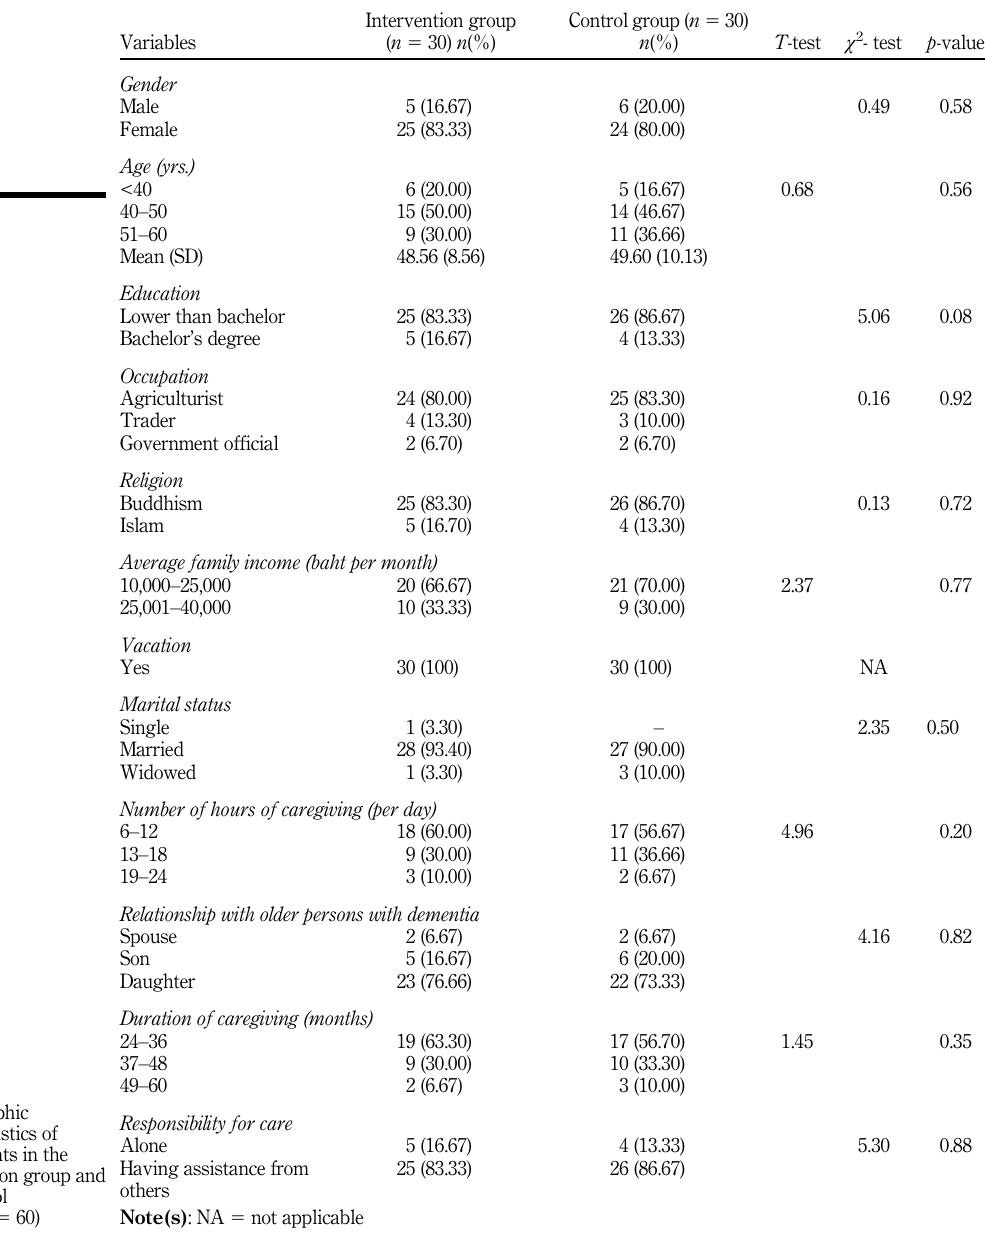
characteristics of participants in the intervention group and the control group ( n 5